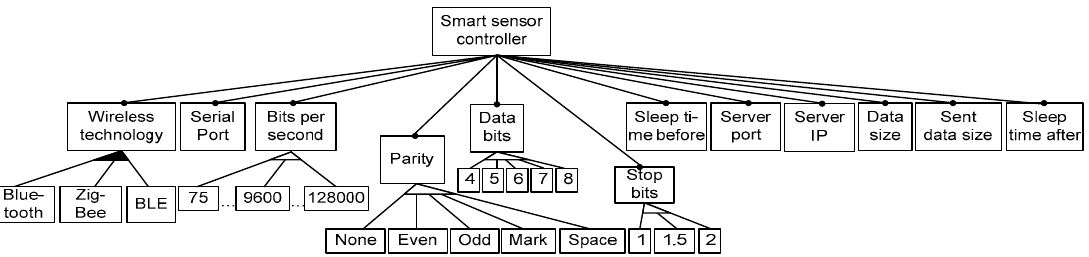
Figure 7. Abstract feature model to specify requirements of BAN-related applications.